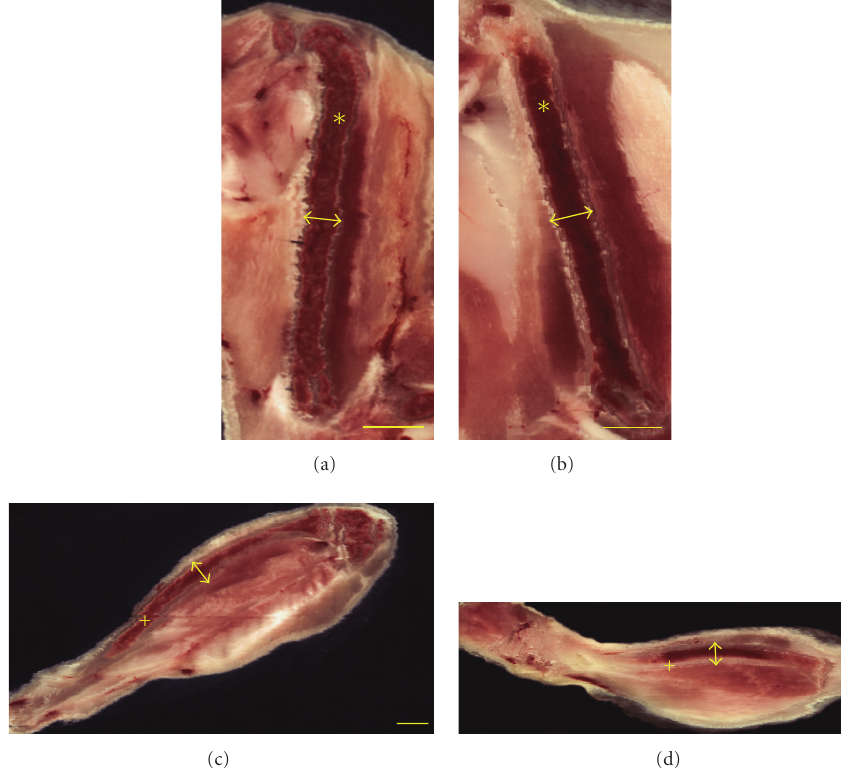
Figure 5: Bone Morphometry. Digital resections along the femur ((a), (b)—marked ∗ ) and tibia ((c), (d)—marked +) for the PEPCK-C mus (a, c) and control mouse (b, d) obtained through multiplanar reformatting of the 3D data. Linear distance was computed to ascertain bone lengths. The femur measured 11.46 mm (PEPCK-C mus ) and 12.41 mm (control) while the tibia measured 17.26 mm (PEPCK-C mus ) and 15.12 mm (control). The tibia to femur length ratio was 24% higher for the PEPCK-C mus mouse as compared to the control animal. Cortical areas were measured mid diaphyseally in cross-sections at positions indicated by arrows (Bar =